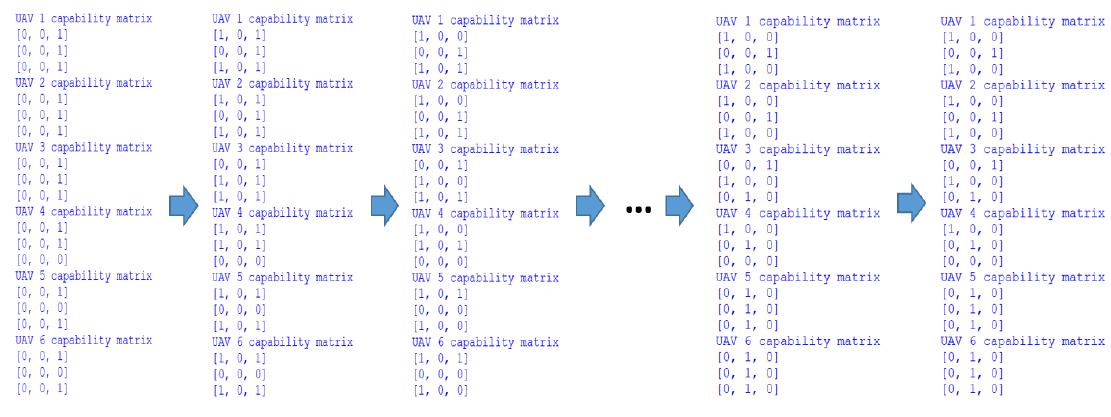
Figure 17. Explanation of capability matrix.